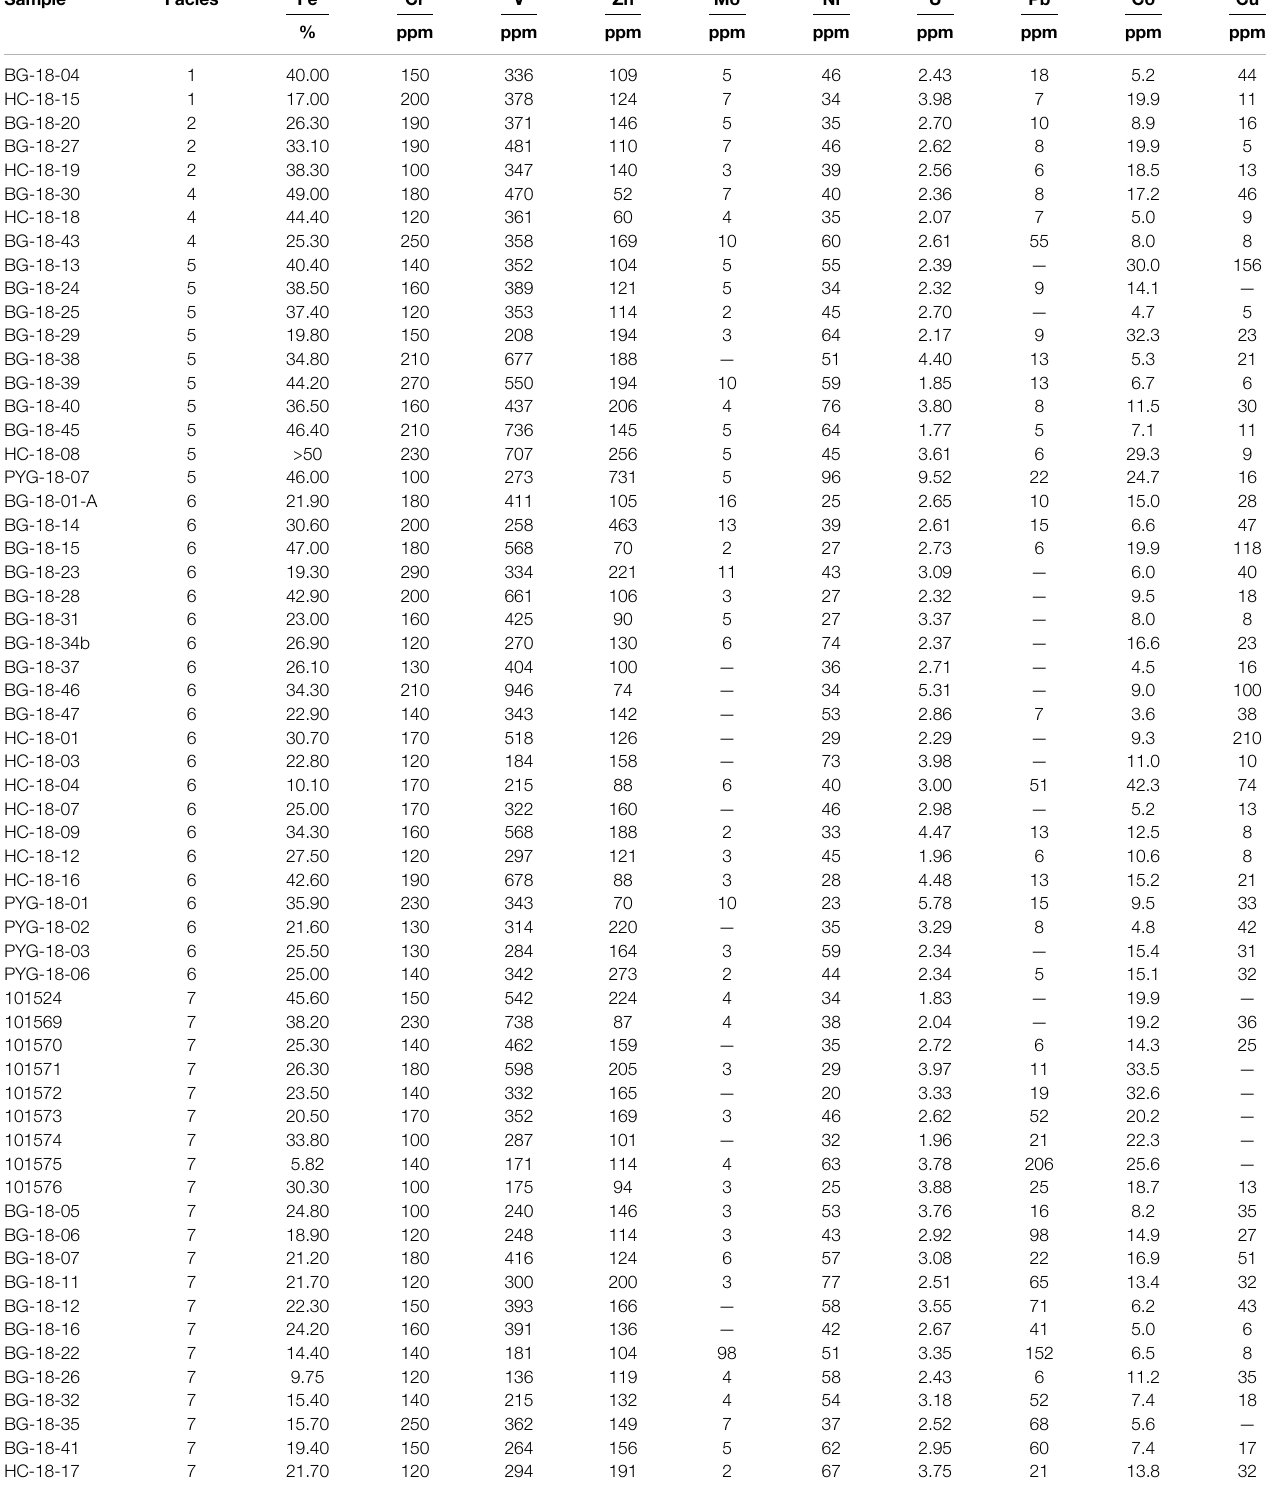
TABLE 3 | Trace metal concentrations + Fe in lithofacies of the Hen-dy-Capel Ironstone Member, Tygarn Formation.